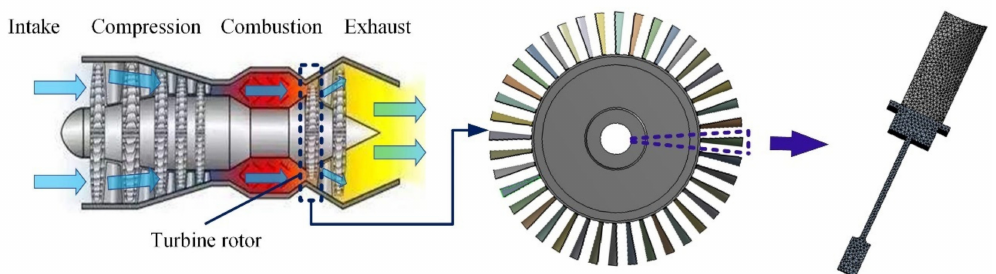
Figure 6. Schematic diagram of aeroengine turbine rotor.